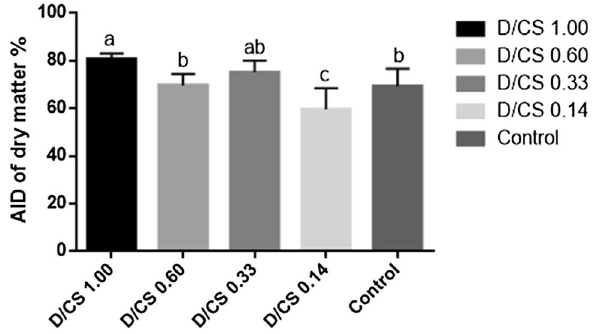
Figure 1. The AID of dry matter in the ileum of broiler chickens ( n = 6). Labeled means without a common letter are significantly different, P < 0.05.